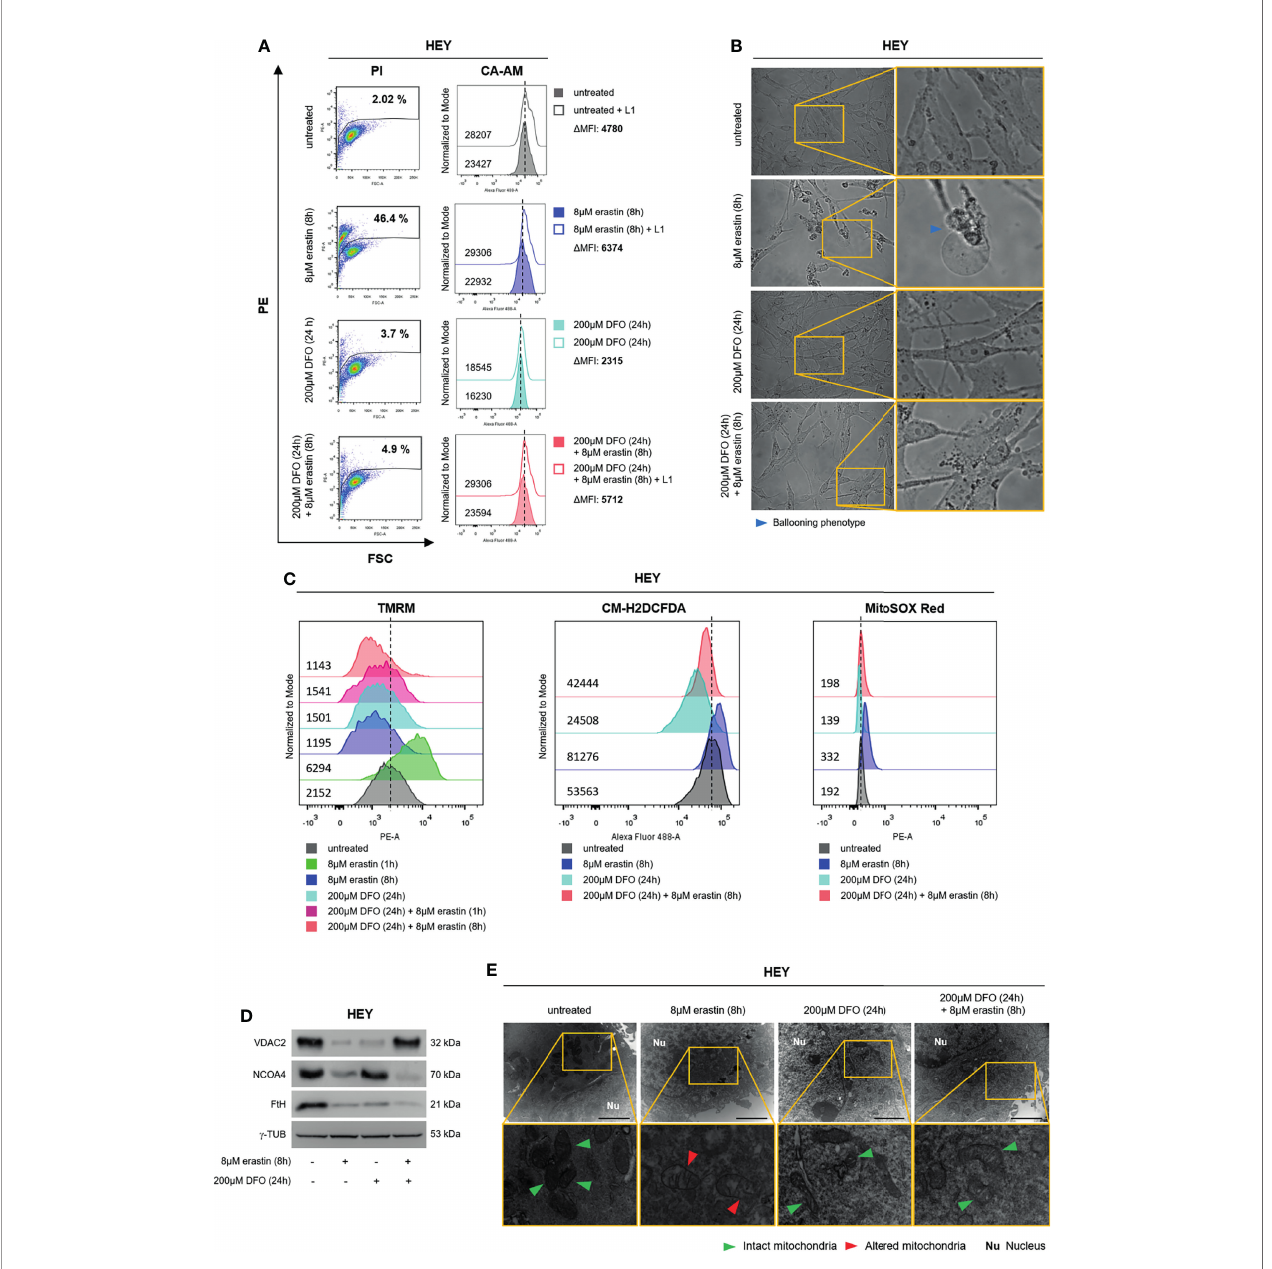
FIGURE 4 | DFO administration protects HEY cells from ferroptosis. (A) LIP level and cell mortality determined using CA-AM and PI cyto fl uorimetric assays in HEY cells untreated, treated with 8 µM erastin (8 h) and 200 µM DFO (24 h) alone or in combination. (B) Optical microscopy images showing the presence or absence of the ballooning phenotype in HEY cells upon treatment with erastin and DFO alone or in combination. (C) Analysis of mitochondrial membrane potential, cytosolic and mitochondrial ROS production by TMRM, CM-H2DCFDA, and MitoSOX Red fl uorescence, respectively, in HEY cells untreated, treated with erastin and DFO alone or in combination. (D) Western Blot of VDAC2, NCOA4, and FtH in HEY cells upon administration of erastin and DFO alone or in combination. g -TUB was used as a normalization control for protein quanti fi cation. (E) Mitochondrial ultrastructural images detected by TEM in HEY cells upon treatment with erastin and DFO alone or in combination. Green arrows, intact mitochondria; red arrows, altered mitochondria; Nu, nucleus. All data are representative of three independent